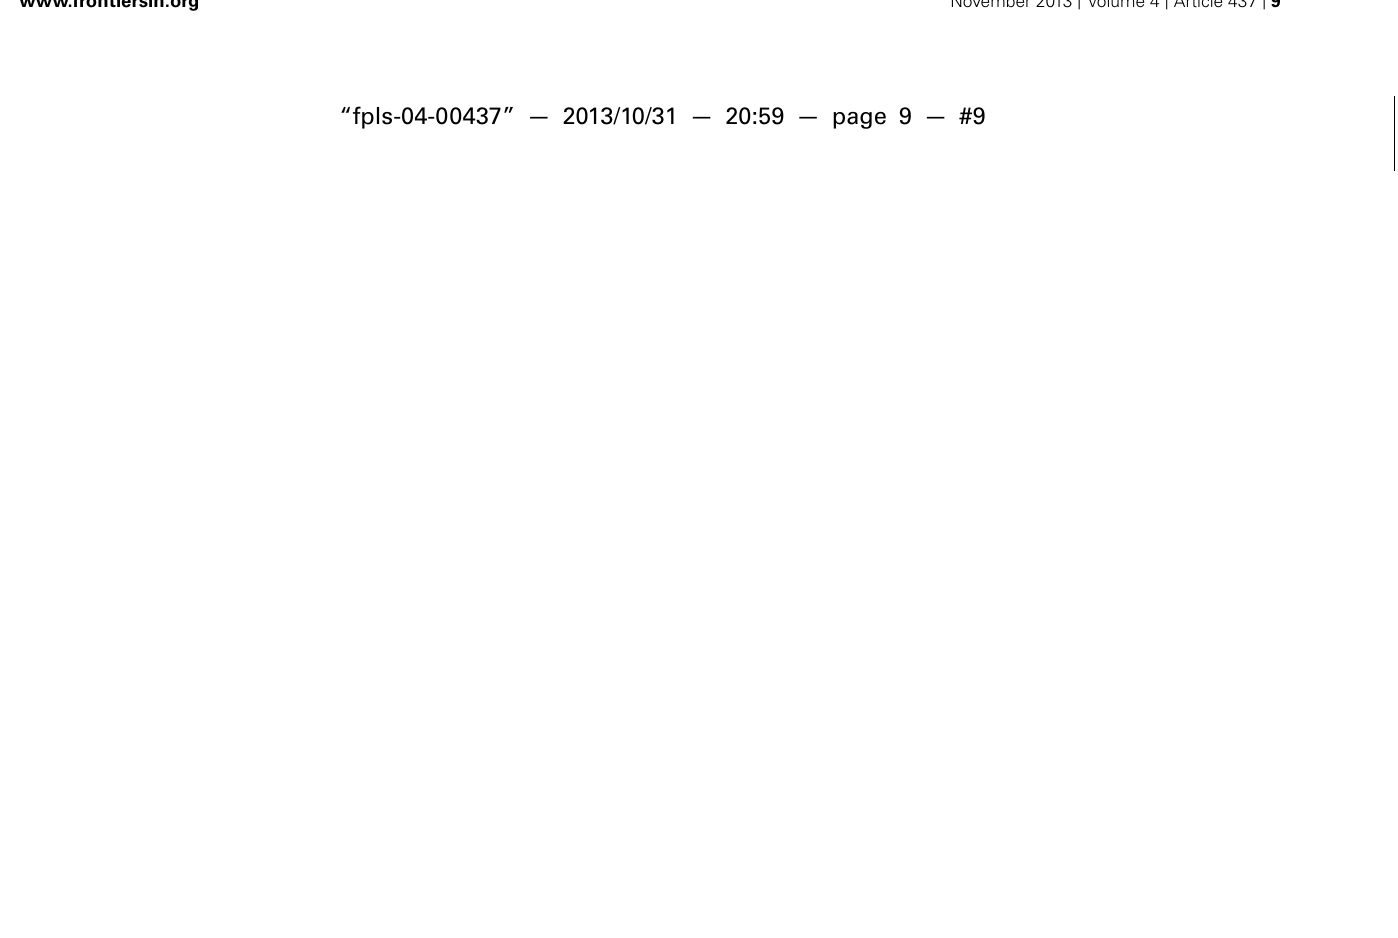
FIGURE 6 | Heatmap representation of the simulated values with X-Palm of C production (A,C) and of non-structural carbohydrate content in trunk (B,D) of oil palm for 50 × 50 combinations of transpiration and leaf appearance rates sensitivity to drought (Leaf appearance_th and Transpiration_th) for the January–April 1989 [severe dry season, precipitation – potential evapotranspiration = − 179 mm (A,B)] and